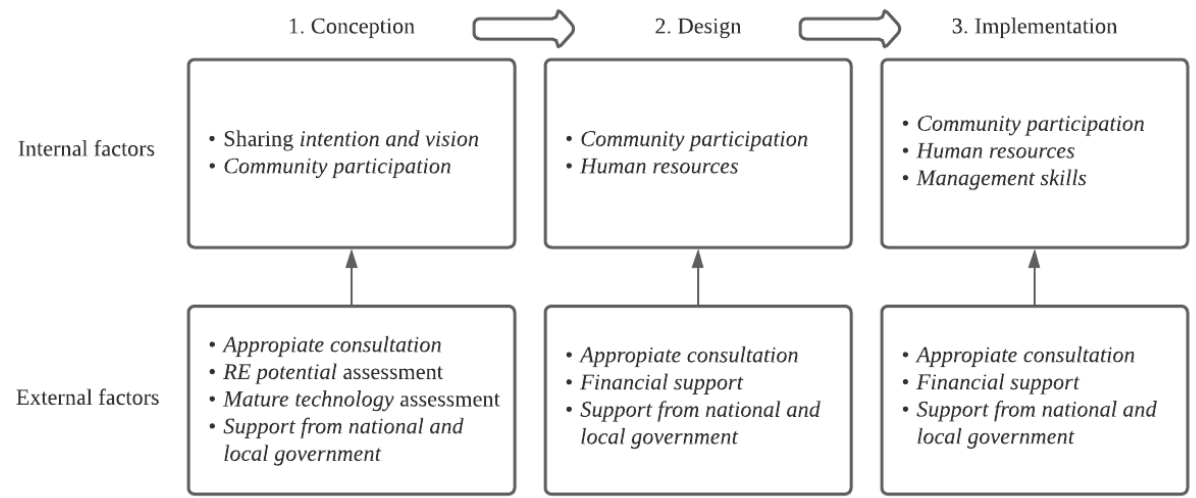
Figure 4. Summary of internal and external conditions and their interaction through a path toward a successful implemen- tation of CRE in Thailand.